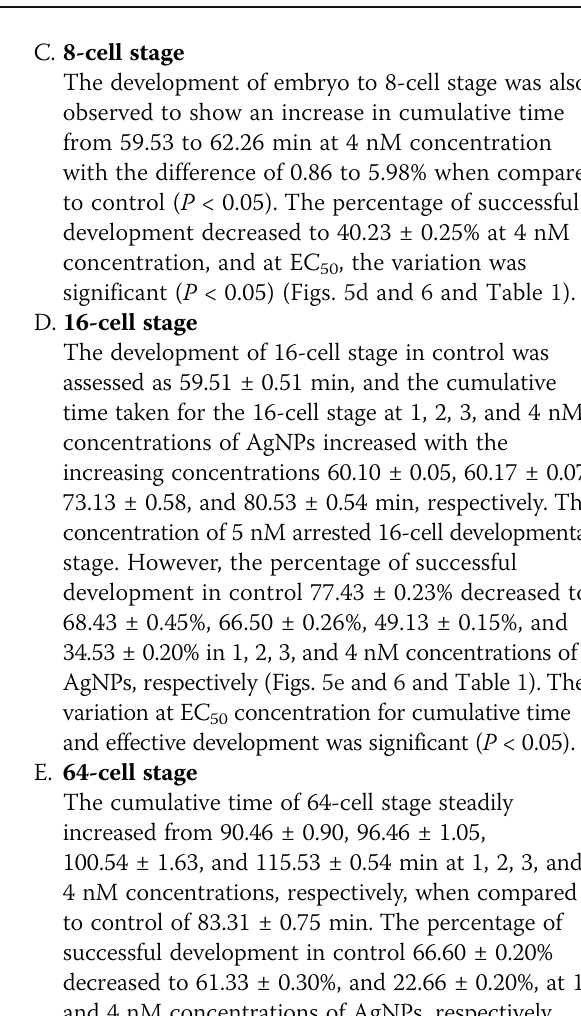
Fig. 2 Field emission scanning electron microscope (FESEM) images of silver nanoparticles showing the particles of spherical